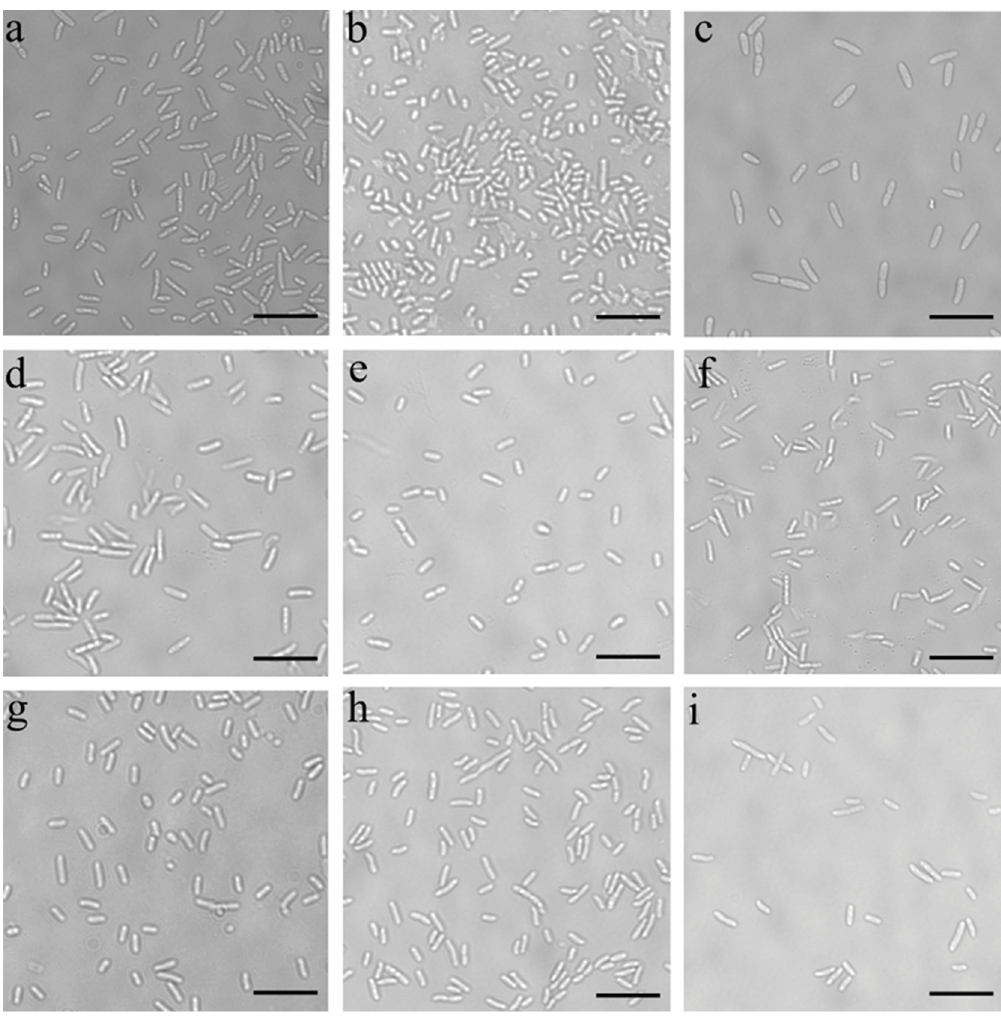
Figure 3. Light microscopy of the growth of the Janthinobacterium sp. SLB01 strain at different tem- peratures and in different media: ( a ) cultivation at 3 °C in PCA; ( b ) cultivation at 3 °C in R 2A; ( c ) temperatures and in different media: ( a ) cultivation at 3 ◦ C in PCA; ( b ) cultivation at 3 ◦ C in R cultivation at 3 °C in LB agar; ( d ) cultivation at 22 °C in PCA; ( e ) cultivation at 22 °C in R 2A; ( f ) cultivation at 22 °C in LB agar; ( g ) cultivation at 30 °C in PCA; ( h ) cultivation at 30 °C in R 2A; ( i ) cultivation at 30 °C in LB agar. Scale bar 10 µm.